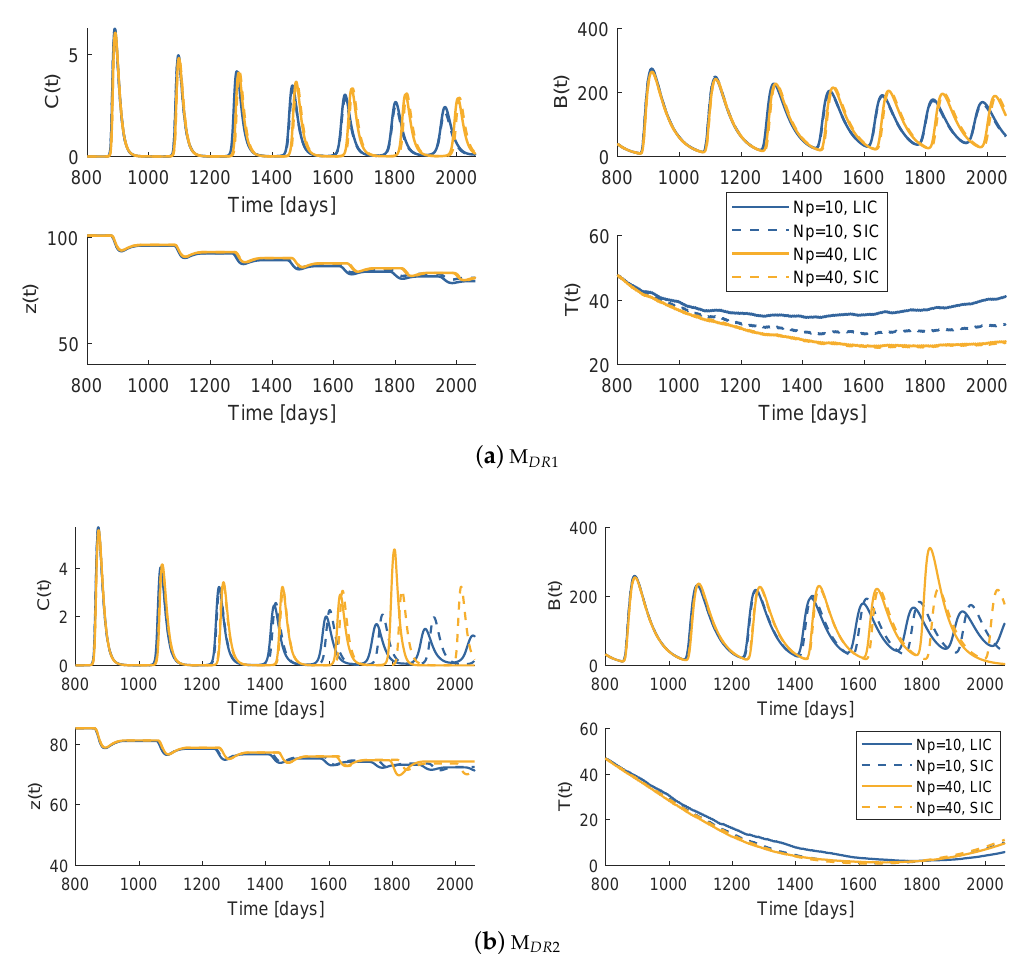
Figure 18. Comparison between the system behaviour when the initial global best position of the PSO is the standard regimen (dashed lines) and a tenth of these values (solid lines). Legend: LIC—Low initial condition of the PSO, SIC—Standard initial condition of the